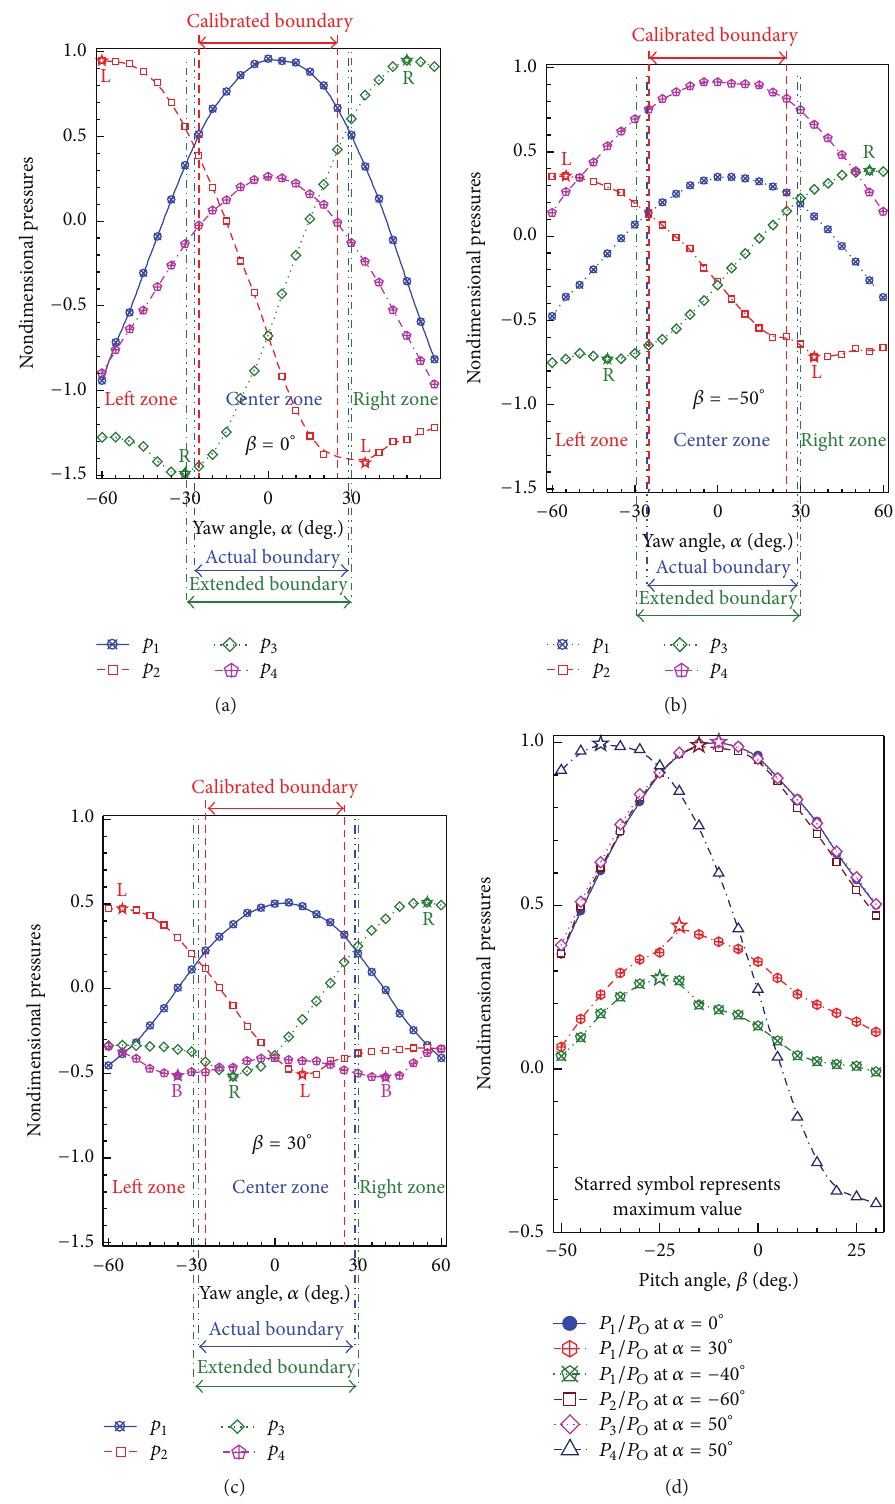
Figure 4: Pressure distributions of the four-hole probe and zone